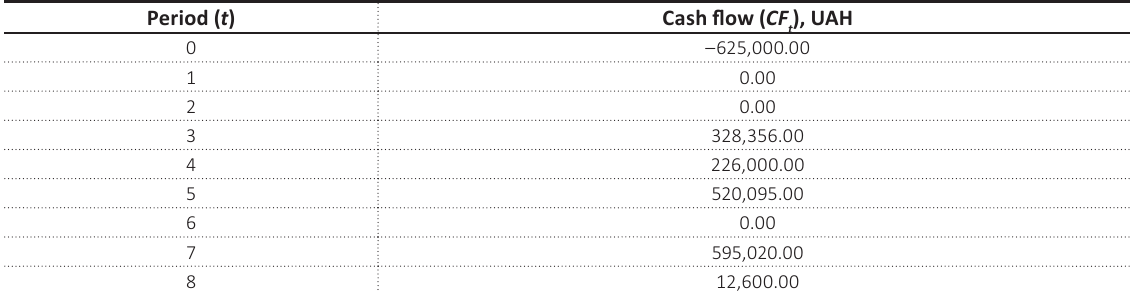
Table 3. Cash flows planed by a potential borrower for loan